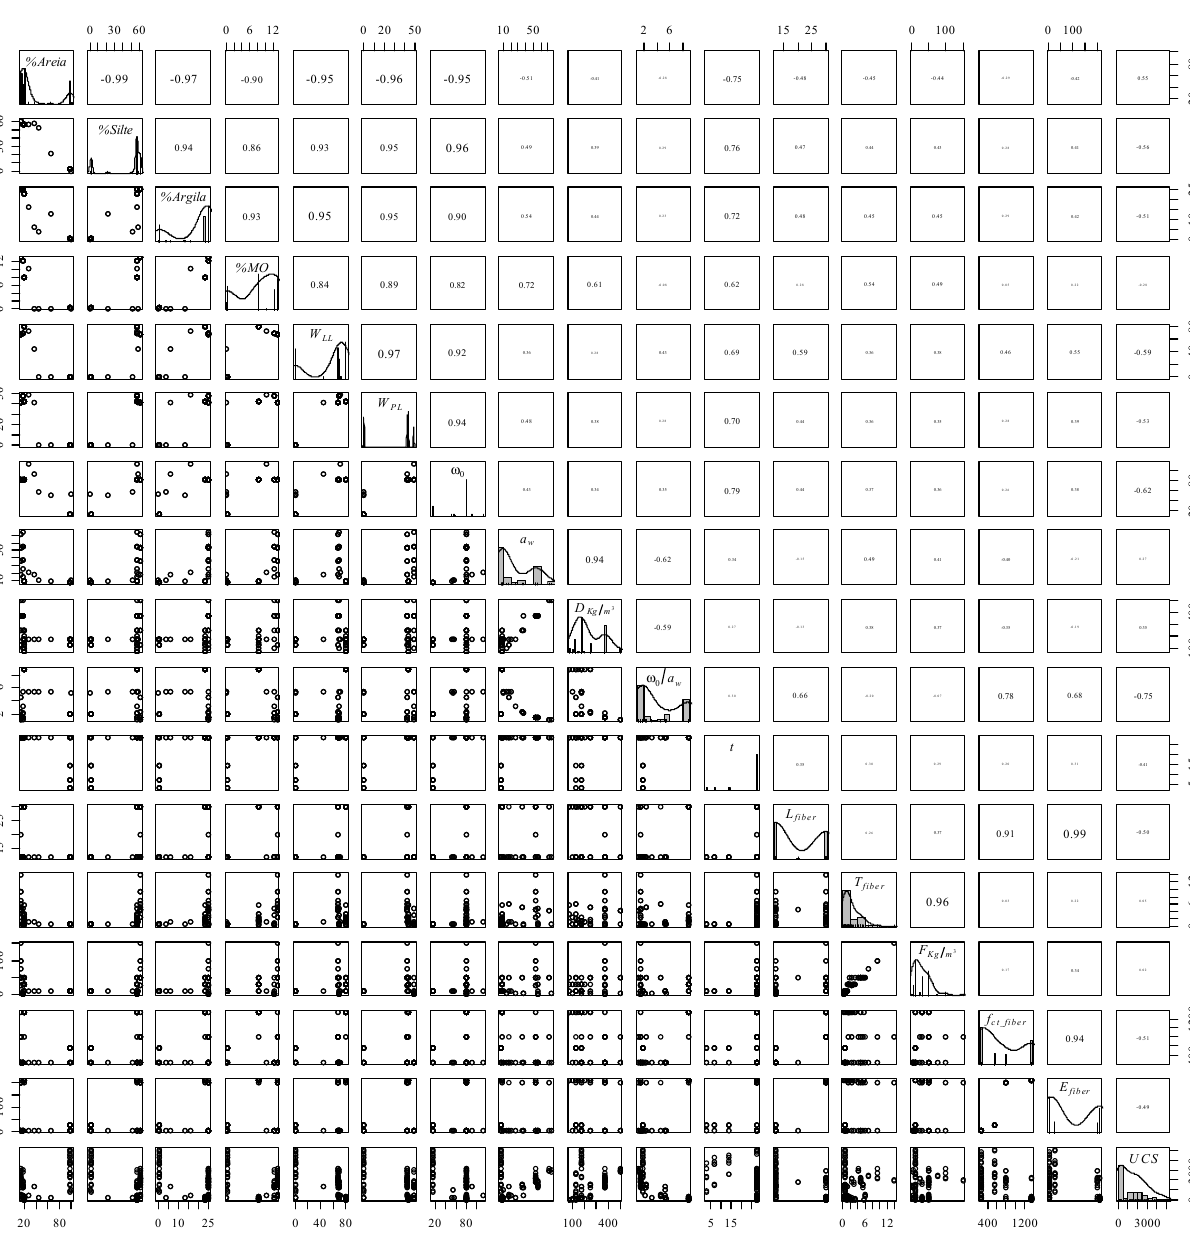
Figure 2. A correlation matrix of all variables considered in the study of UCS prediction of reinforced soil–binder–water mixtures with fibers (scatter plot of matrices (SPLOM), with bivariate scatter plots below the diagonal, histograms on the diagonal, and the Pearson correlation above the diagonal).